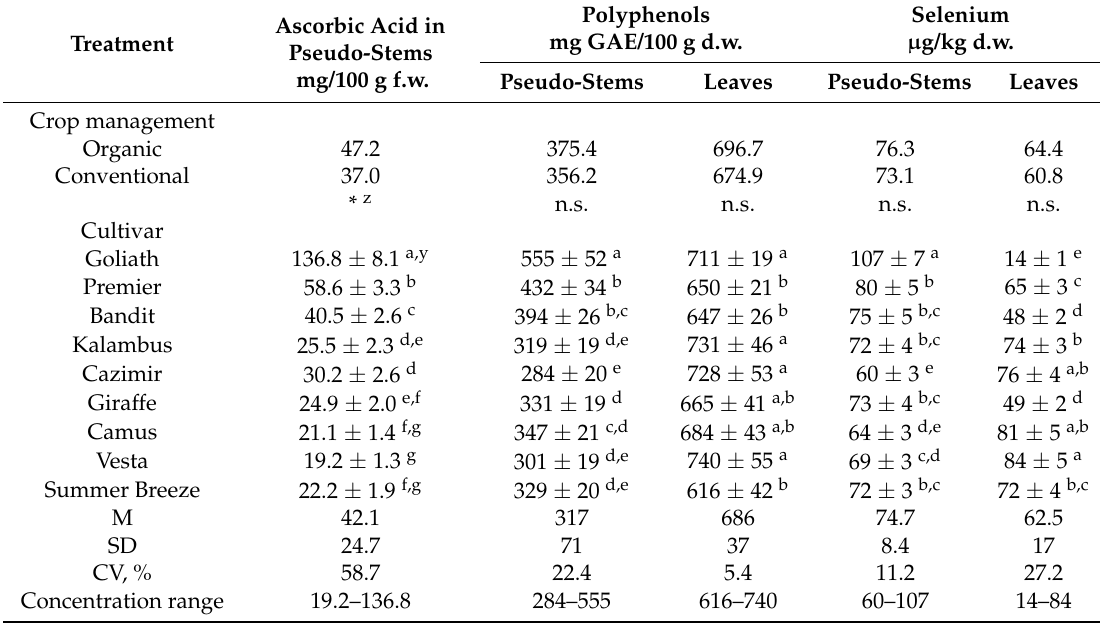
Table 2. Concentrations of ascorbic acid, polyphenols and selenium in